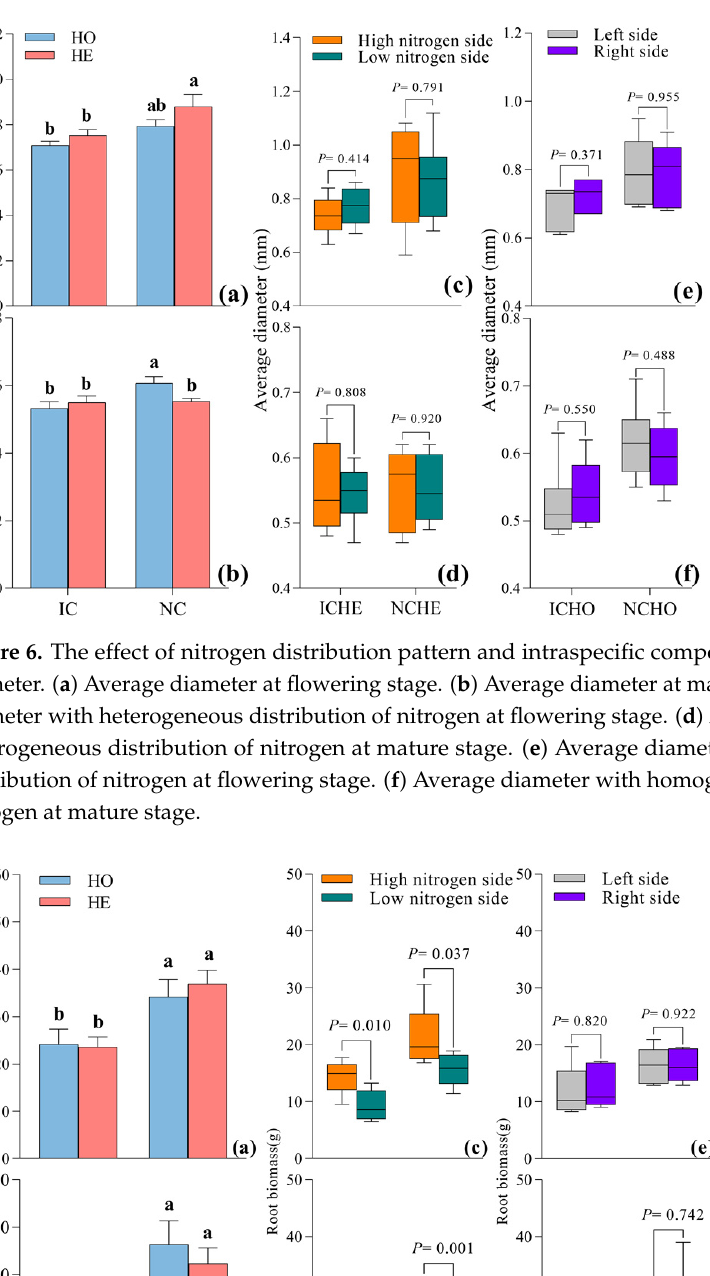
8 of 15 Figure 5. Effect of nitrogen distribution pattern and intraspecific competition on specific root length. ( a ) Specific root length at flowering stage. ( b ) Specific root length at mature stage. ( c ) Under hetero- geneous nitrogen distribution conditions, specific root length at flowering stage with intraspecific competition. ( d ) Under heterogeneous nitrogen distribution conditions, specific root length at ma- ture stage with intraspecific competition. ( e ) Under homogeneous nitrogen distribution conditions, specific root length at flowering stage with no competition. ( f ) Under homogeneous nitrogen distri- bution conditions, specific root length at mature with no competition. In both intraspecific competition and no competition, the nitrogen distribution pat- terns did not differ significantly on the root average diameter at the flowering stage (Fig- ure 6a). All showed a heterogeneous nitrogen distribution over a homogeneous nitrogen distribution, and, at the mature stage, the differences were not significant for intraspecific competition and significantly higher for no competition homogeneous nitrogen than for the heterogeneous nitrogen distribution. The differences in the root average diameter be- tween the high and low nitrogen side pots of the heterogeneous nitrogen distribution were not significant at the flowering (Figure 6c) and mature stages (Figure 6d), nor were the